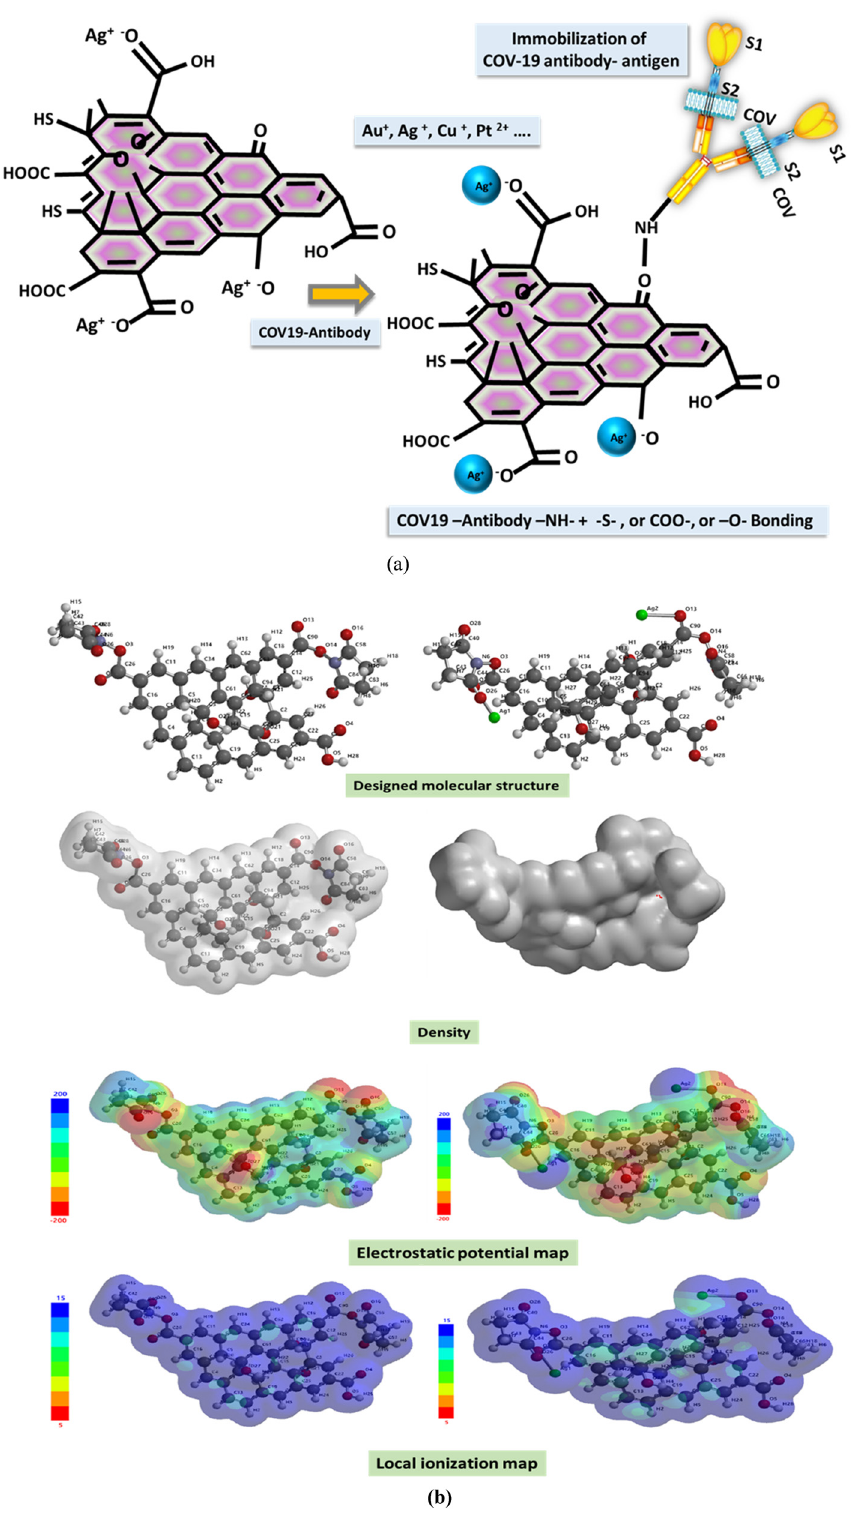
Figure 5: ( a ) Overall steps for the targeted COV19 – Antibody – NH − + – S − , or COO − , or − O - bonding formation of the GO - based composites; ( b ) model structure, electron density, interaction potential and dynamic